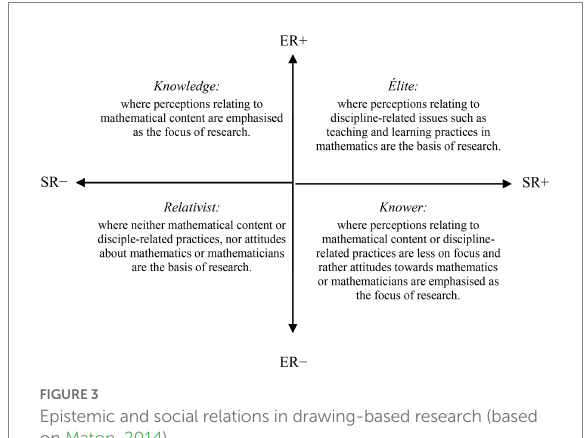
FIGURE 3 Epistemic and social relations in drawing-based research (based on Maton,